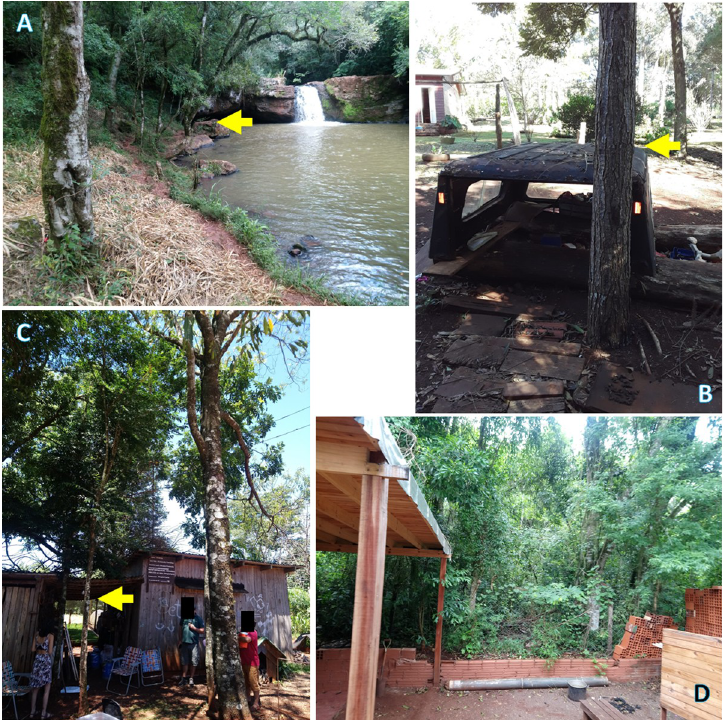
Fig 5. Environments where Lonomia spp. was found in Misiones, Argentina. A - A forest area. B - A domestic space inside a rural area. Note a metal scrap (commonly used by children to play) next to the host tree. C - A home garden in a peri-urban area. D - The backyard of the house (in a neighborhood of Puerto Iguazu´ city) where a moth of Lonomia was collected: note its proximity to the Iguazu´ National Reserve. In Fig 5A–5C, the yellow arrow indicates the tree hosting Lonomia